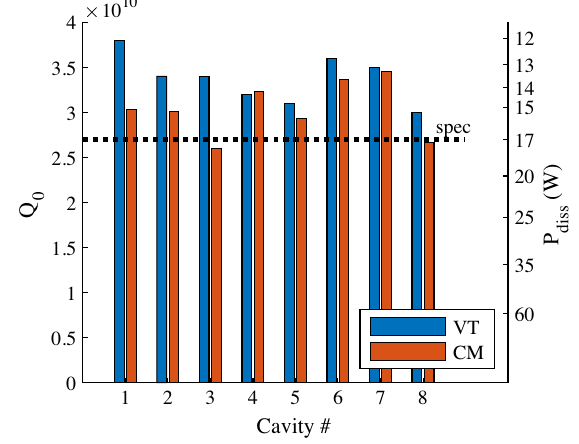
FIG. 12. Q 0 in the cryomodule compared to Q 0 in VT. Measurements were made at the nominal gradient ( 21 MV = m).